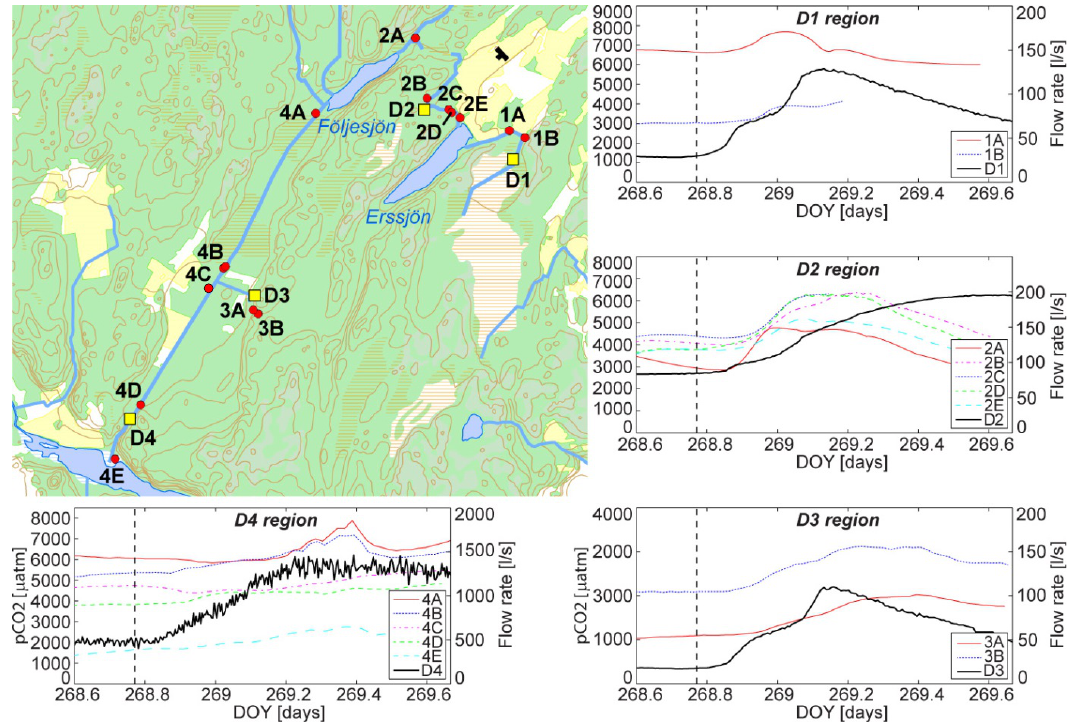
Figure 9. Example of 24h of data from 14 CO 2 logger-chamber units placed in the main streams in a catchment stream network to log stream p CO 2aq . Yellow squares (D1–D4) denote water discharge stations representing stream regions and the water flows from D1 to D4; the D3 stream is a tributary which joins the main stream upstream of station D4. The red dots represent the CO 2 logger-chamber units. Data (with the initial time of chamber equilibration removed) are displayed region-wise in the sub-panels together with the measured discharge. A rain event caused an increase in the discharge half way through the measurement period which seems related with increased p CO 2aq in most locations. DOY denotes day of the year. The map is published with permission from Lantmäteriet, Sweden, according to agreement i2012/898 with Linköping